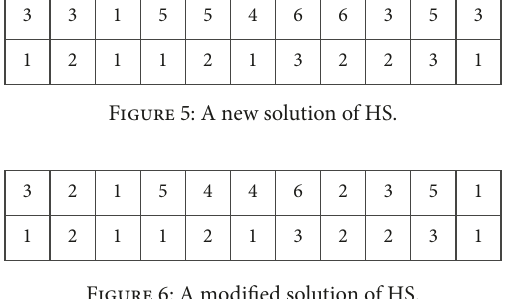
Figure 6: A modified solution of